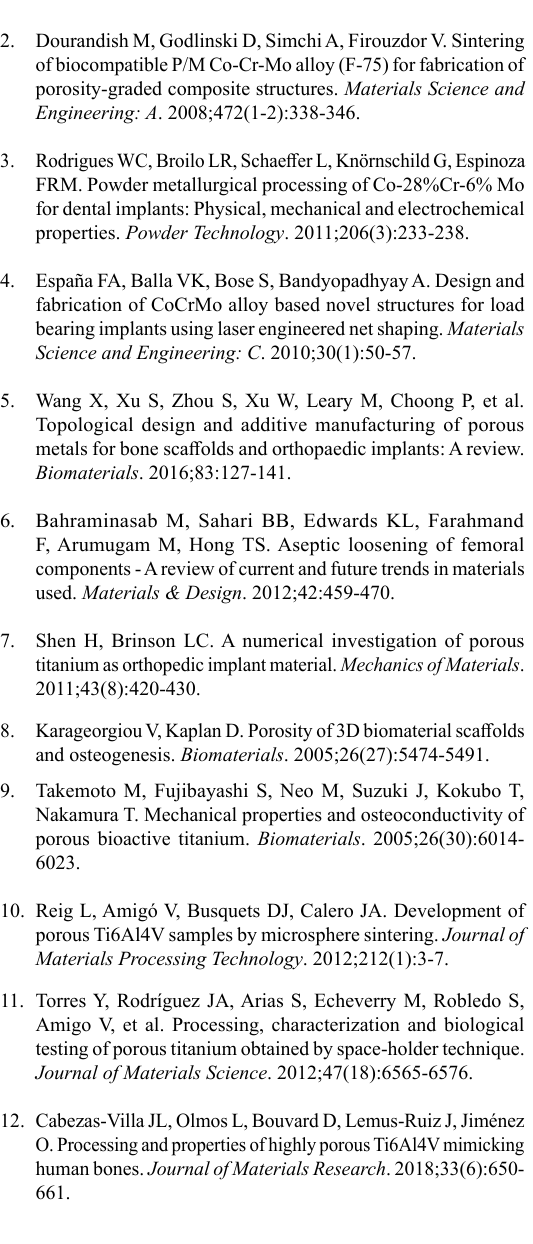
Figure 8. SEM micrographs of the microhardness indentations on both phases of the composite: a) matrix and b) eutectic Ti